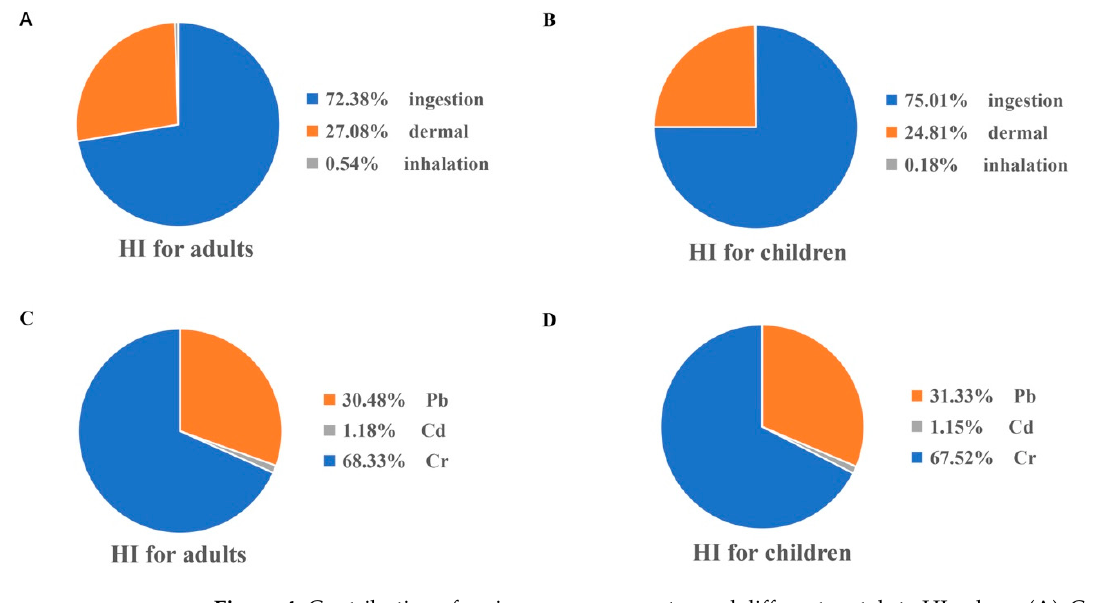
Figure 4. Contribution of various exposure routes and different metals to HI values. ( A ): Contribution of various routes to HI values for adults. ( B ): Contribution of various routes to HI values for children. ( C ): Contribution of different metals to HI values for adults. ( D ): Contribution of different metals to HI values for children.